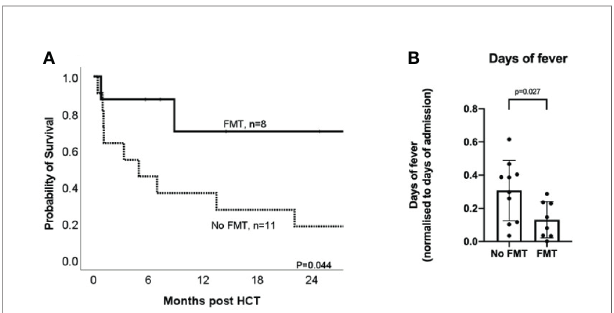
FIGURE 2 | Impact of FMT on clinical outcomes for MDRO-colonized patients receiving HCT. (A) Kaplan-Meier curve of overall survival in MDRO- colonized HCT patients who underwent FMT ( ‘ FMT ’ , solid line; n = 8) and those who did not (No FMT, n = 11); (B) Comparison of days of fever (normalized for days of admission, i.e. number of days with fever divided by total number of admission days) in MDRO colonized HCT patients who underwent FMT ( ‘ FMT ’ ) vs those who did not ( ‘ No FMT ’